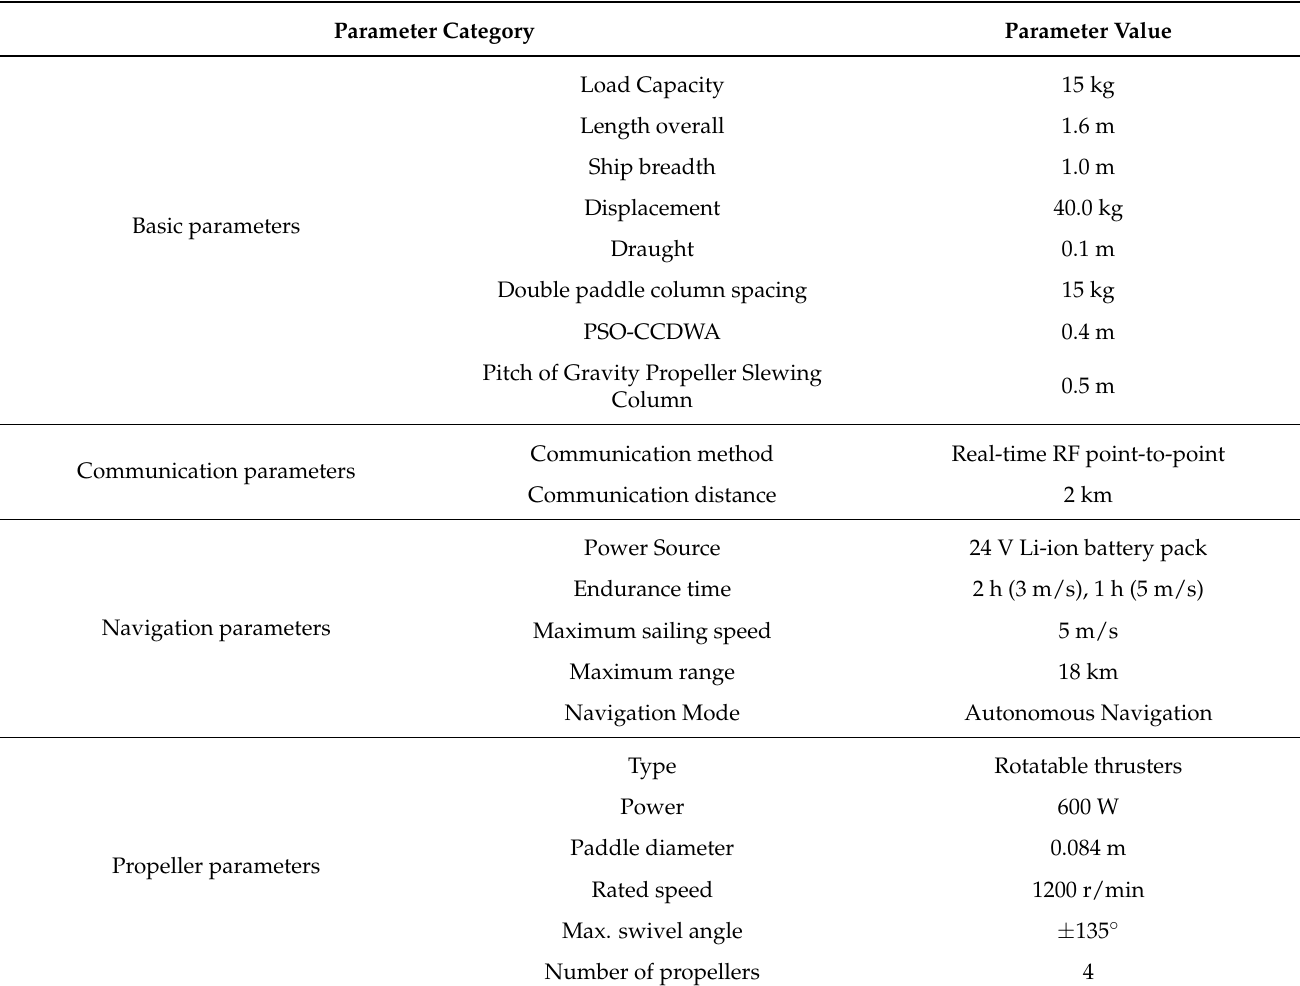
Table 7. USV “Buffalo”